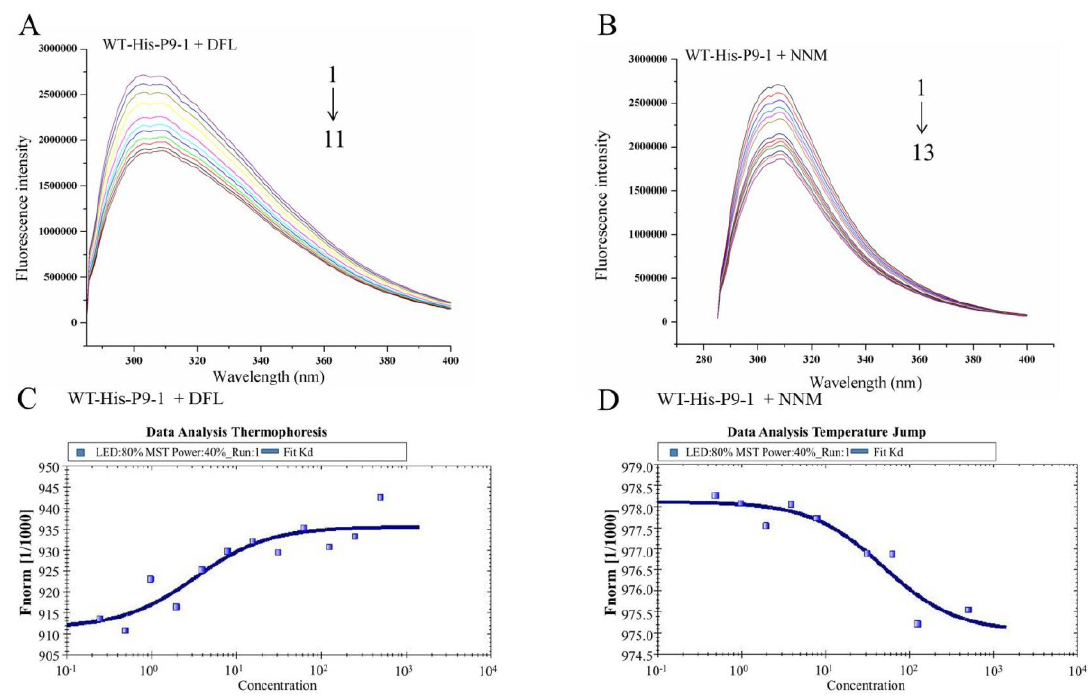
Figure 4. Binding affinity and specificity of DFL and NNM to WT-His-P9-1 protein. ( A ) Fluorescence emission spectra of WT-His-P9-1 in the presence of DFL, C WT-His-P9-1 : 20 μM, C DFL : 1–11: 0, 2.0, 4.0, 6.0, 8.0, 10.0, 12.0, 14.0, 16.0, 18.0, 20.0 μM. ( B )